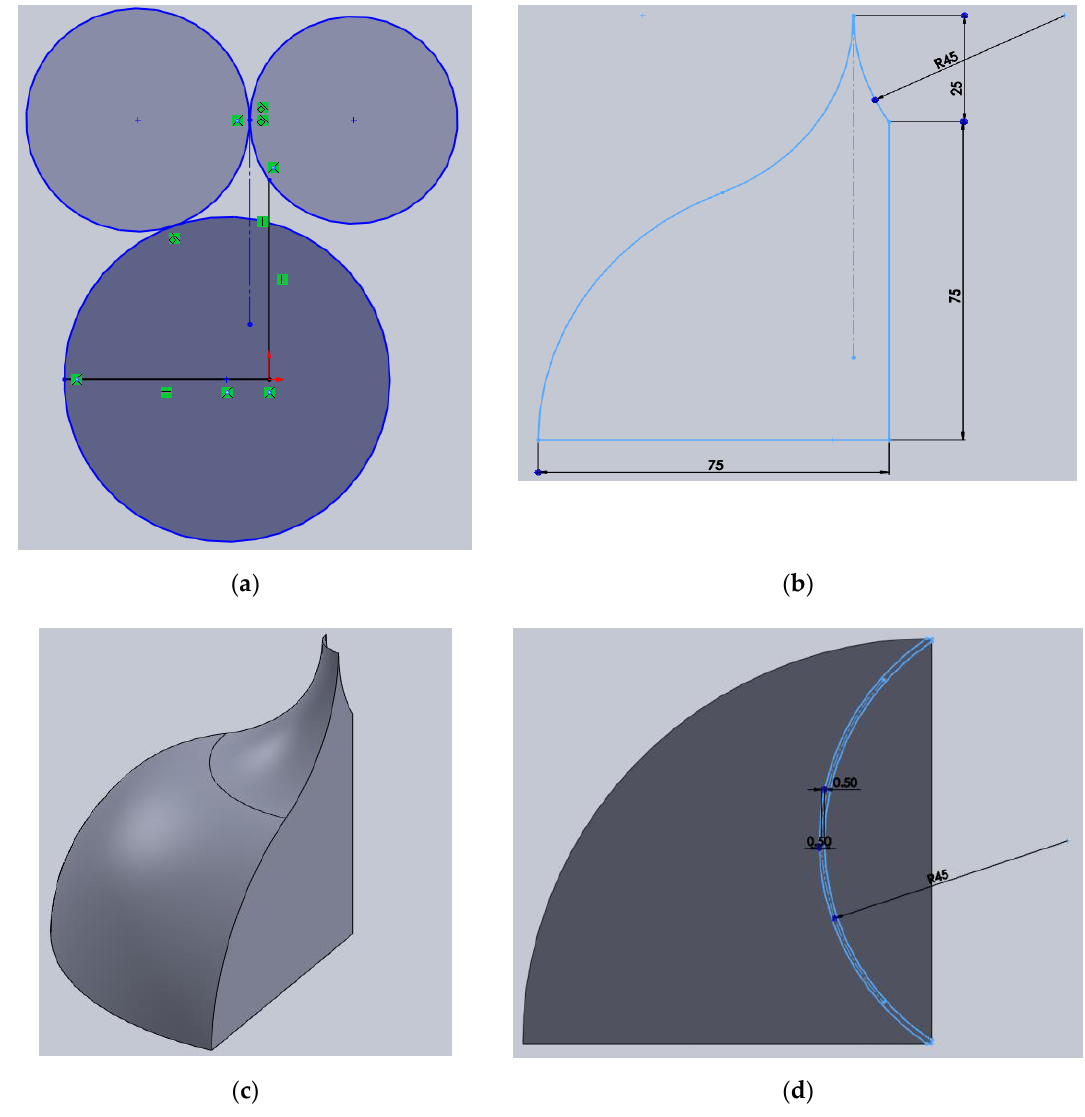
Figure 3. Steps used in SolidWorks to draw the IceWind blade (dimensions are in mm). ( a ) First shape; ( b ) trimmed shape; ( c ) revolved shape; ( d ) preparation of extruded cut shape .